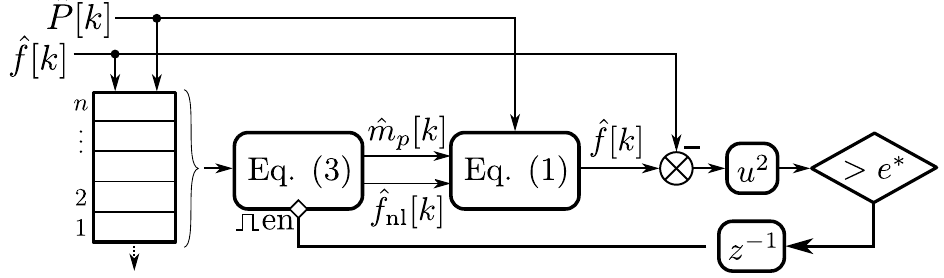
Figure 4. Block diagram of the proposed linear regression algorithm.